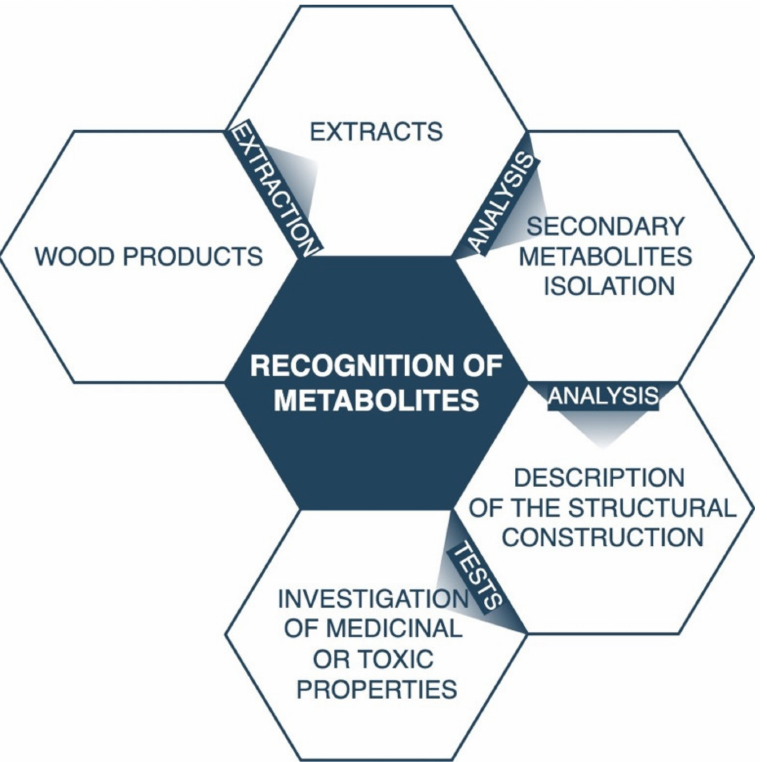
Figure 4. A simplified process of identifying secondary metabolites obtained in vitro from wood